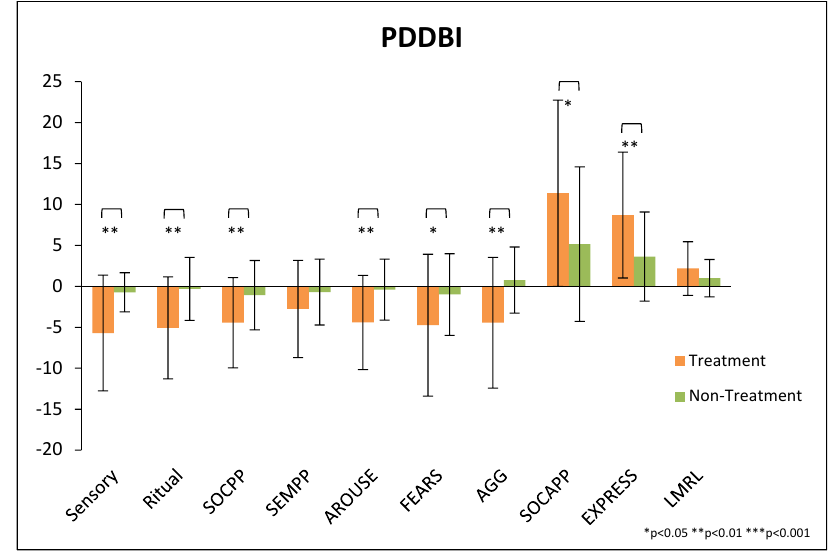
Figure 8. Change in PDD ‐ BI subscale scores. Note that the first seven subscales are for maladaptive behaviors, so a decrease is beneficial. The last three subscales are for adaptive behaviors, so an increase is beneficial. Error bars represent standard deviations.